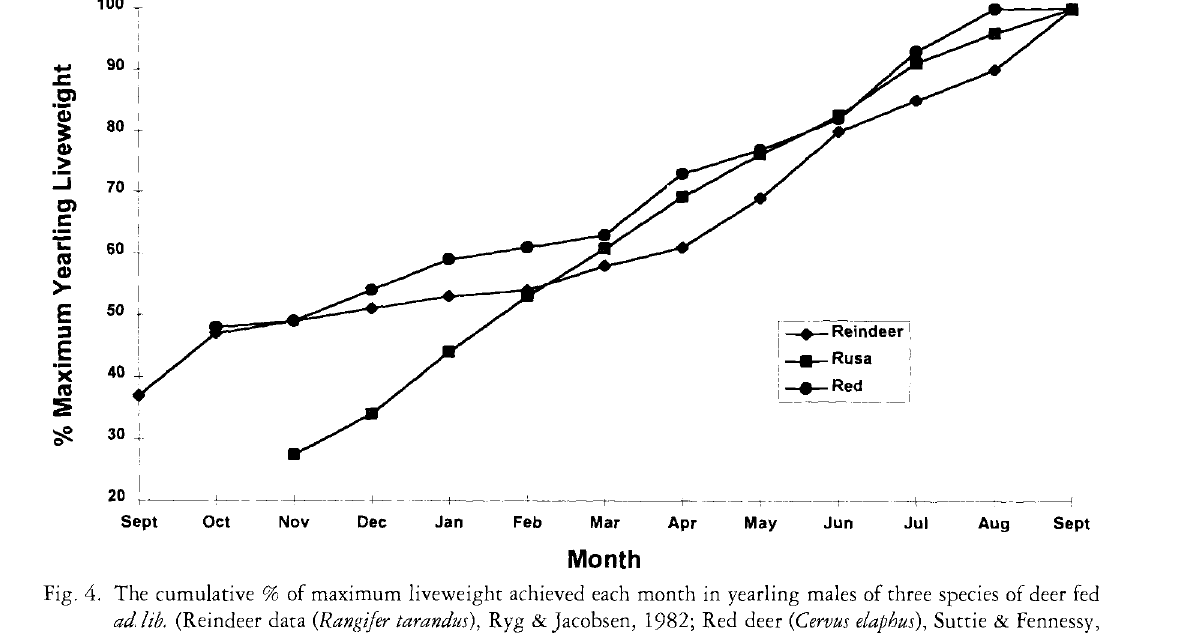
Fig. 4. The cumulative % of maximum liveweight achieved each month in yearling males of three species of deer fed ad lib. (Reindeer data (Rangifer tarandus), Ryg & Jacobsen, 1982; Red deer (Cervus elapbus), Suttie & Fennessy, unpubl.; Rusa deer (Cervus rusa), Suttie & Woodfotd,